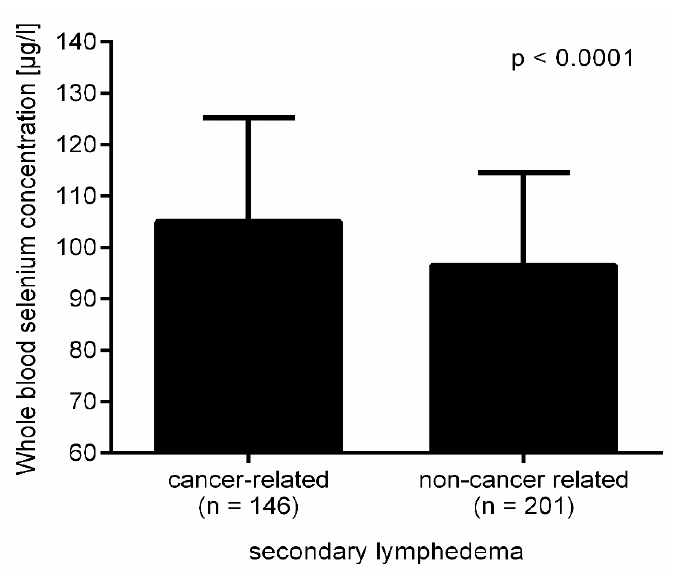
Figure 1. Decreasing selenium values with increasing lymphedema stage.